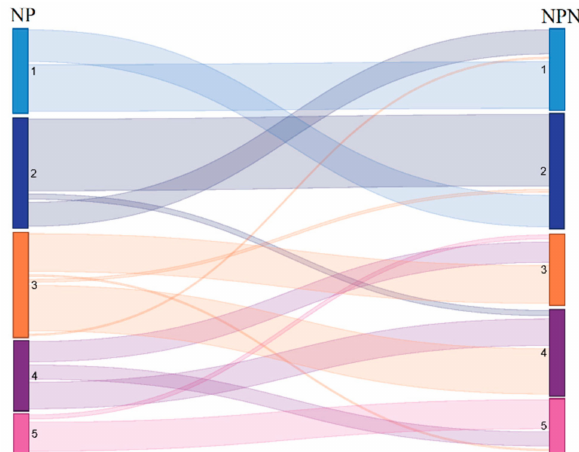
Figure 9. Clusters for different classification strategies and the relationships between them (clusters 1 to 5 are arranged in order of TOD values from largest to smallest).